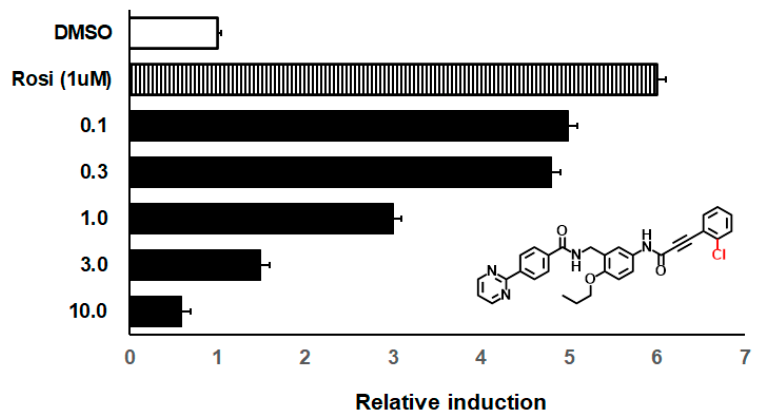
Figure 9. The effect of 13m on the 1-induced adipogenesis of 3T3-L1 cells. After pretreatment with 1 (1 mM) and 5 mg/mL insulin, 3T3-L1 cells were incubated with the indicated concentrations of 39p. Oil red O-stained cells are quantified at the bottom in terms of OD 490 . Data are presented as fold induction relative to the DMSO control. All data points represent the averages of triplicate samples (±SD).